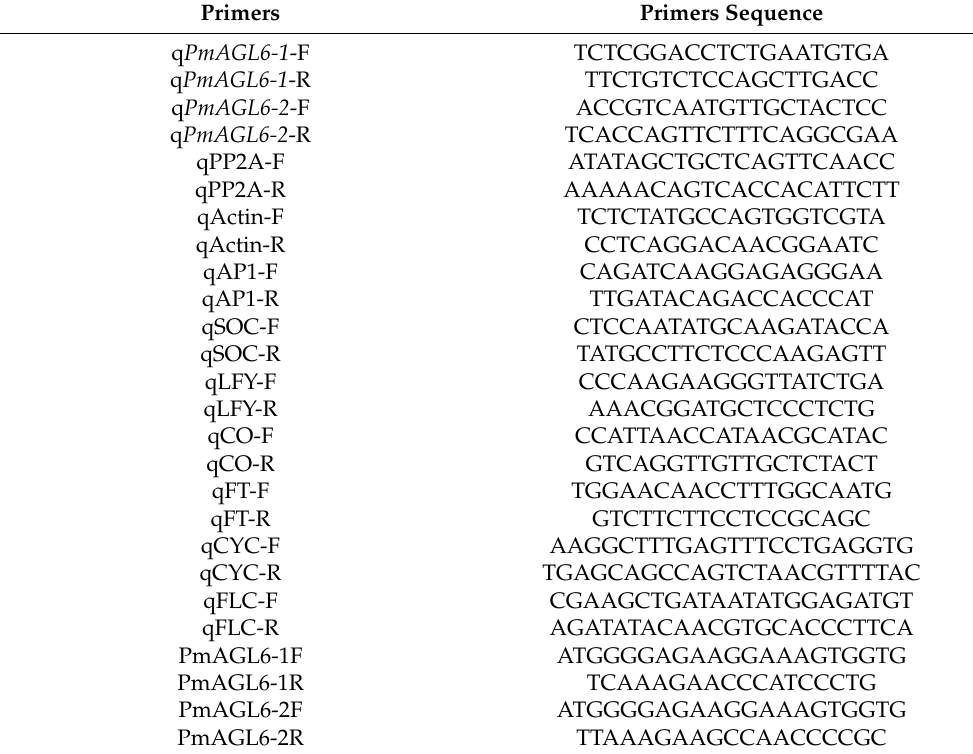
Table 1. Primers for